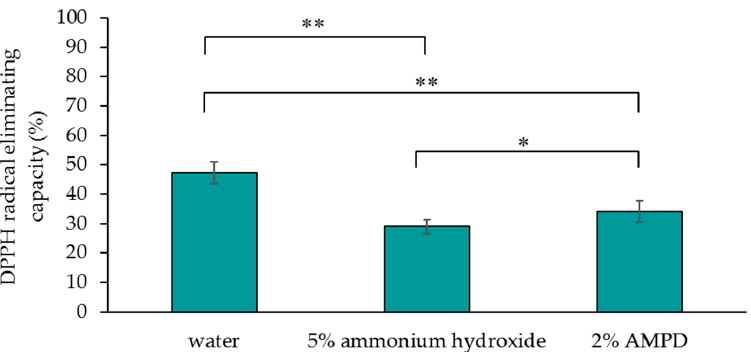
Figure 4. Comparison of the 1,1-diphenyl-2-picrylhydrazyl (DPPH) radical-eliminating capacity of human hair immersed in pure water (control), human hair bleached with H 2 O 2 and 5% ammonium hydroxide, and human hair bleached with H 2 O 2 and 2% AMPD aqueous solution. The results are expressed as the mean ± standard deviation of fifteen experiments. * p < 0.05, ** p < 0.01.